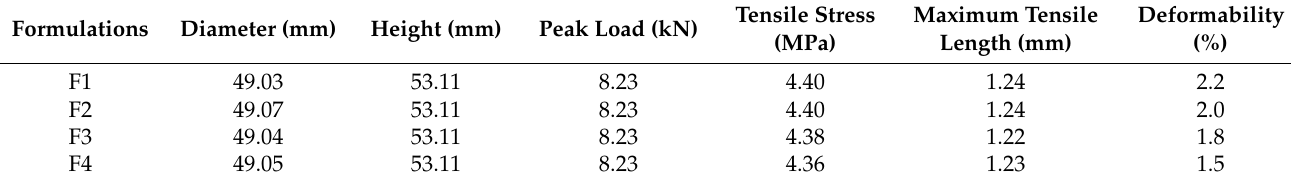
Table 4. Deformability of SN-modified underwater composite-repairing materials.